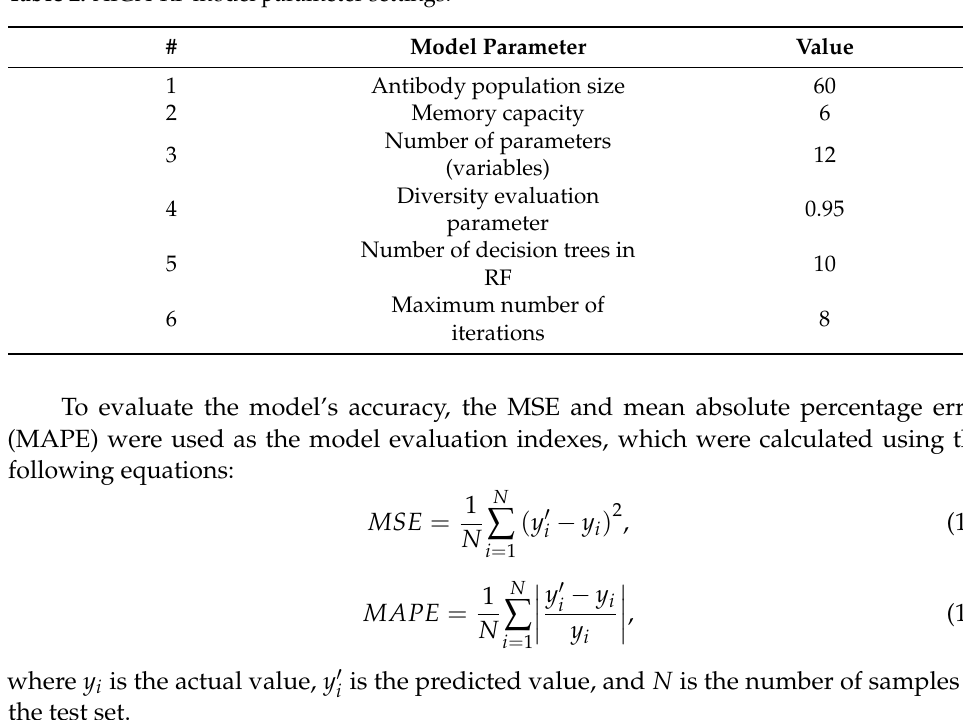
Table 2. AIGA-RF model parameter